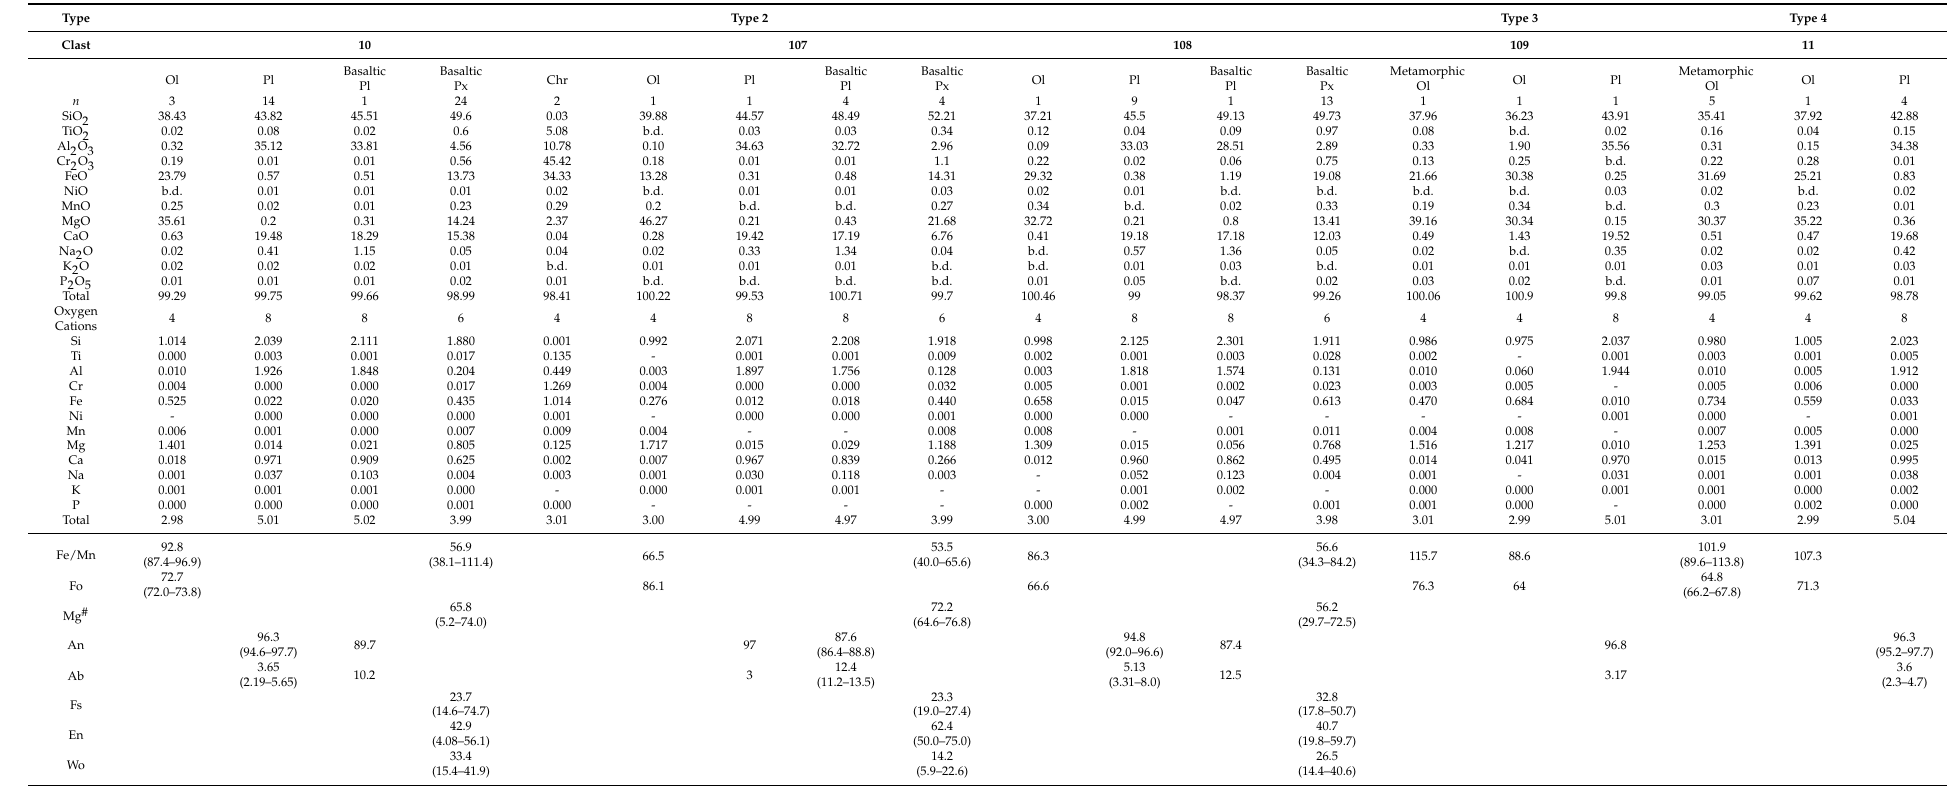
Table 2. Compositions of representative minerals in different types of crystalline impact melt